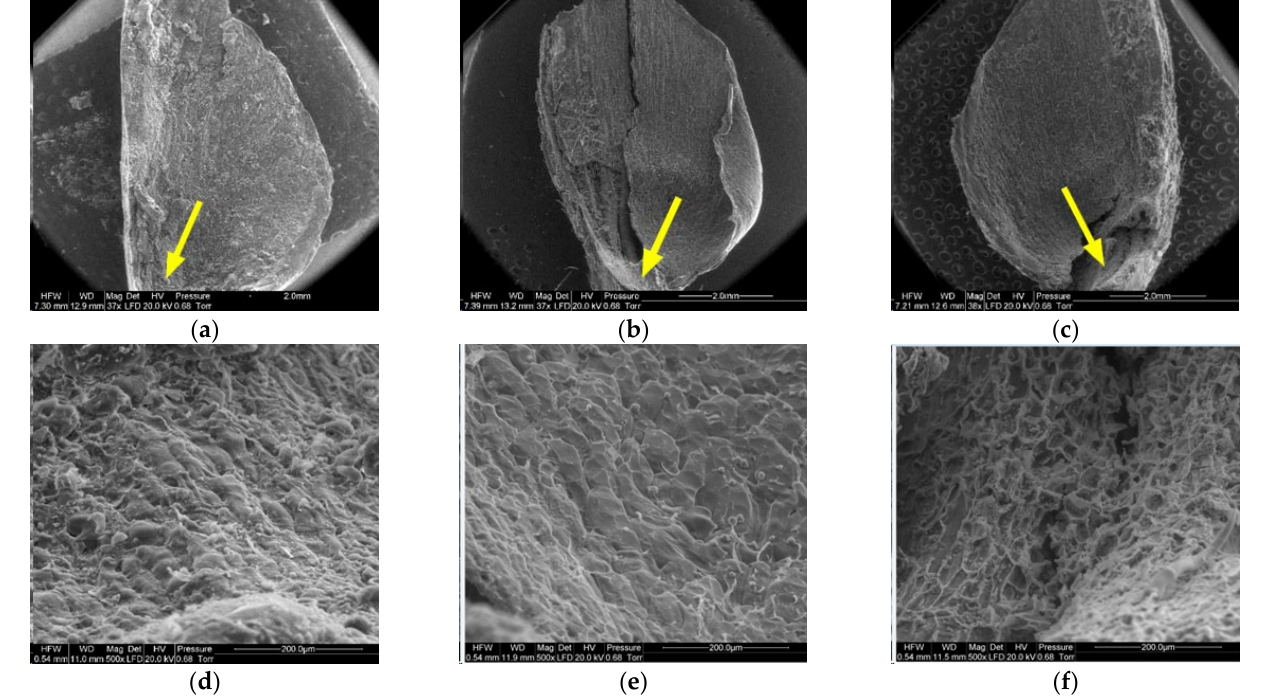
Figure 10. Inner side of larch scale. Seed depression area: ( a ) MC = 20%, zoom 50×; ( b ) MC = 10%, zoom 50×; ( c ) MC = 5%, zoom 50×; ( d ) MC = 20%, zoom 500×; ( e ) MC = 10%, zoom 500×; and ( f ) MC = 5%, zoom 500×.